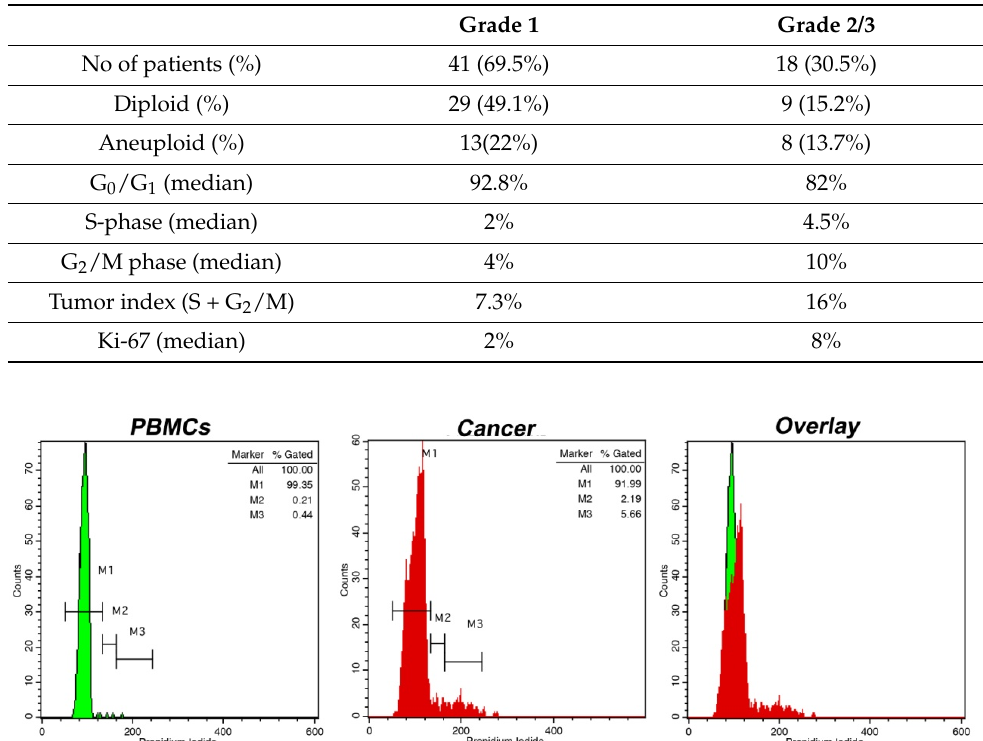
Table 1. Patient characteristics regarding iFC and Ki-67 staining results.